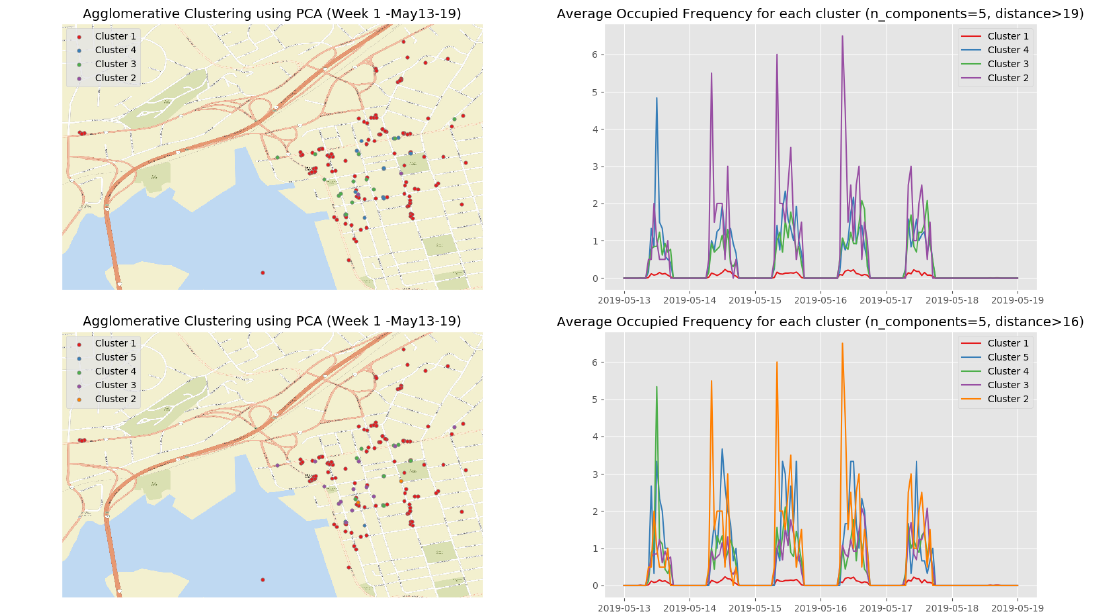
Figure 16. Temporal patterns of occupied/empty events that were computed at the fog